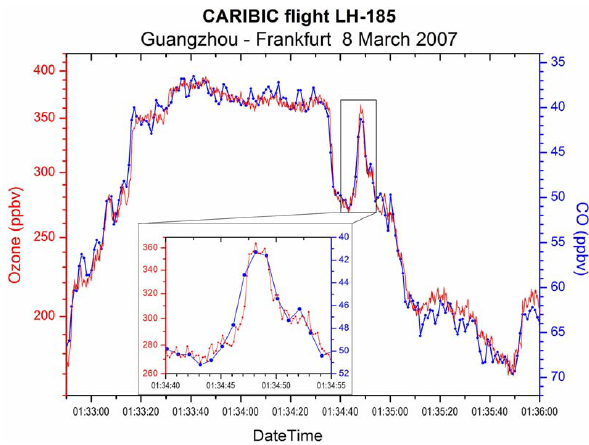
Fig. 4. Fast changes of CO and O 3 concentrations during a section Fig. 4: Fast changes of CO and O 3 concentrations during a section of flight #185 from 3 of flight #185 from Guangzhou to Frankfurt on 8 March 2007. Note Guangzhou to Frankfurt on March 8, 2007. Note the inverse scale for CO. The insert 4 shows a 90 ppbv O 3 peak, with a coinciding 8 ppbv drop in CO over a period of only ~12 5 the inverse scale for CO. The insert shows a 90ppbv O 3 peak, with seconds (blue dots). 6 a coinciding 8ppbv drop in CO over a period of only ∼ 12s (blue 7